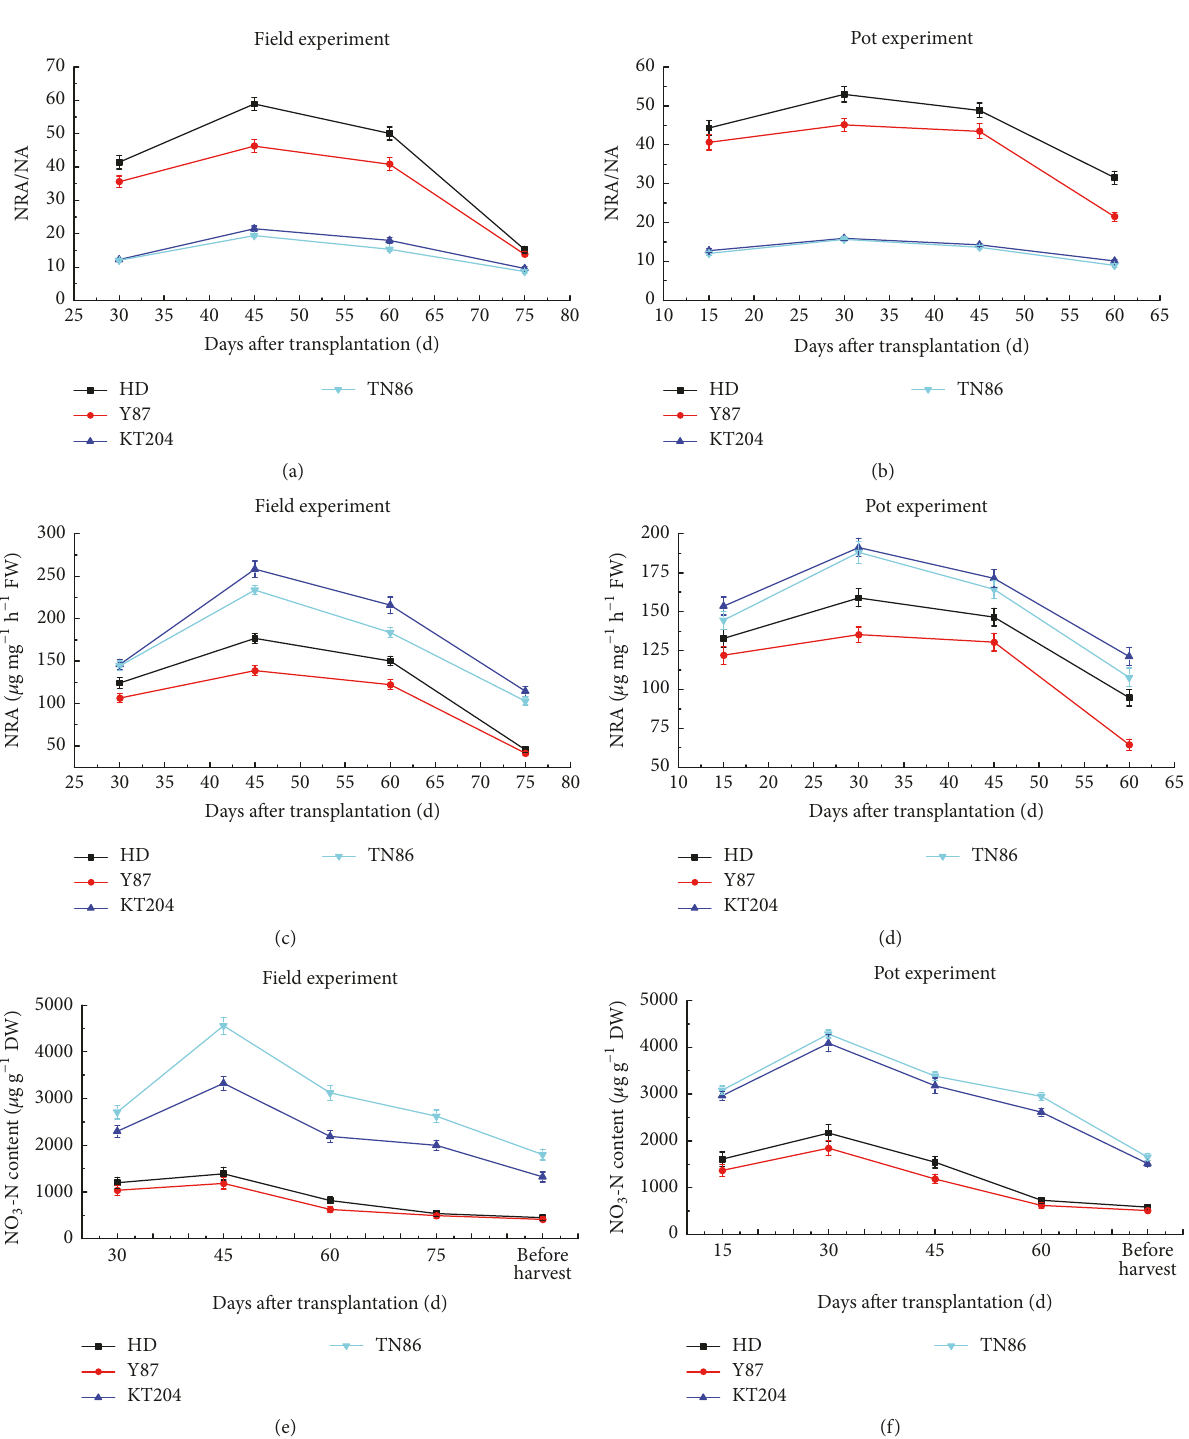
Figure1:Differencebetweenburleytobaccoandflue-curedtobaccoinNRA,NRA/NA,andNO 3 -Ncontentofleaves.Burleytobaccovarieties were KT204 and TN86, and flue-cured tobacco varieties were HD and Y87. NA: nitrogen application (HD and Y87: 45kg ha −2 , KT204 and TN86: 180kg ha −2 ). NRA: nitrate reductase activity. Error bars indicate standard error of the means ( 𝑛 = 3